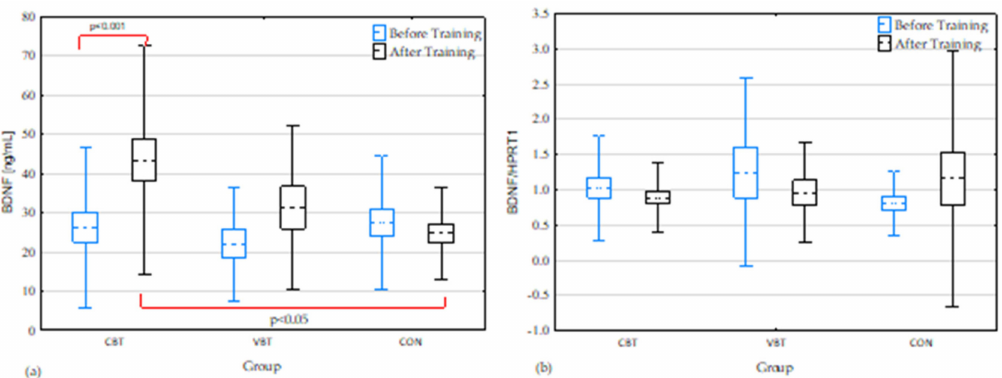
Figure 6. BDNF concentrations ( a ) and expression ( b ) in the blood before and after completion of the 12-week balance training. Significant di ff erences: p < 0.05; mean (—), SEM (box), and SD (whiskers); CBT—classical balance training, VBT—virtual reality balance training, CON—control